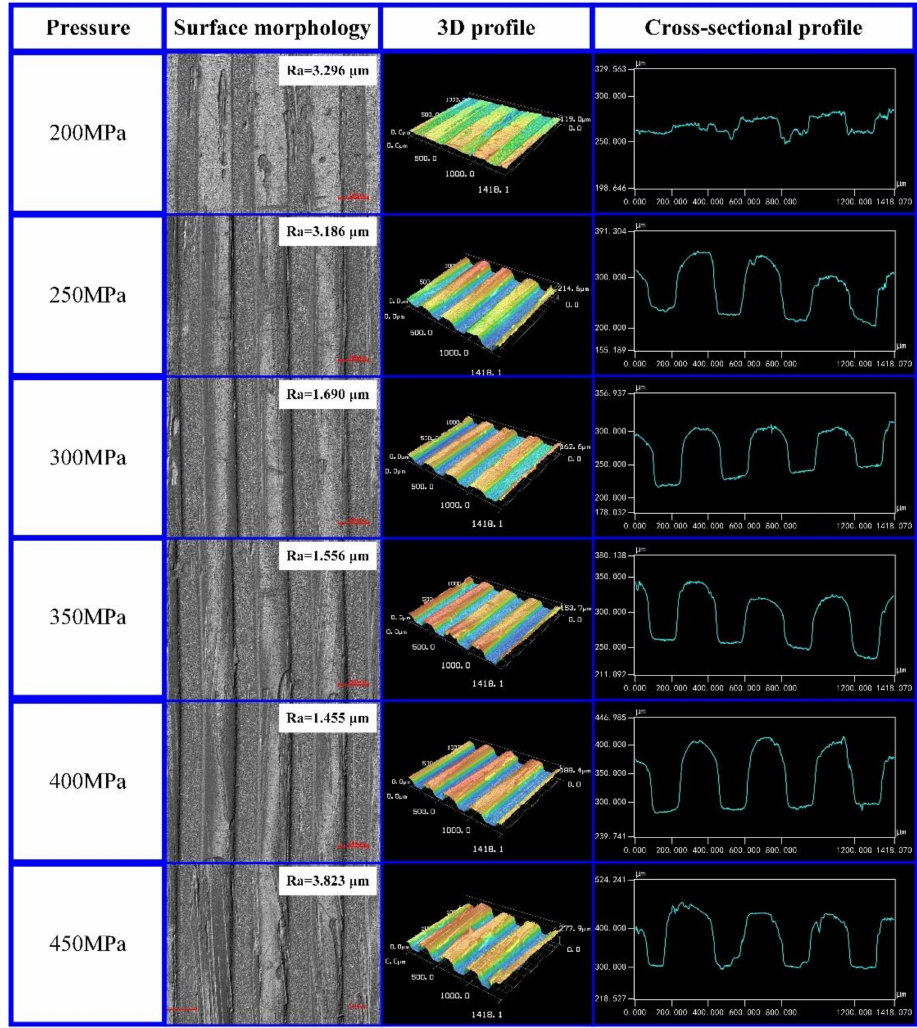
Figure 4. Effect of pressure on the molding quality of the micro-grooves on the CFRP